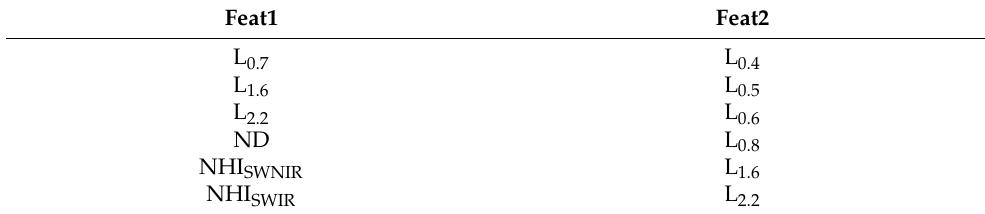
Table 3. Feature sets used for the two models, namely Feat1 and